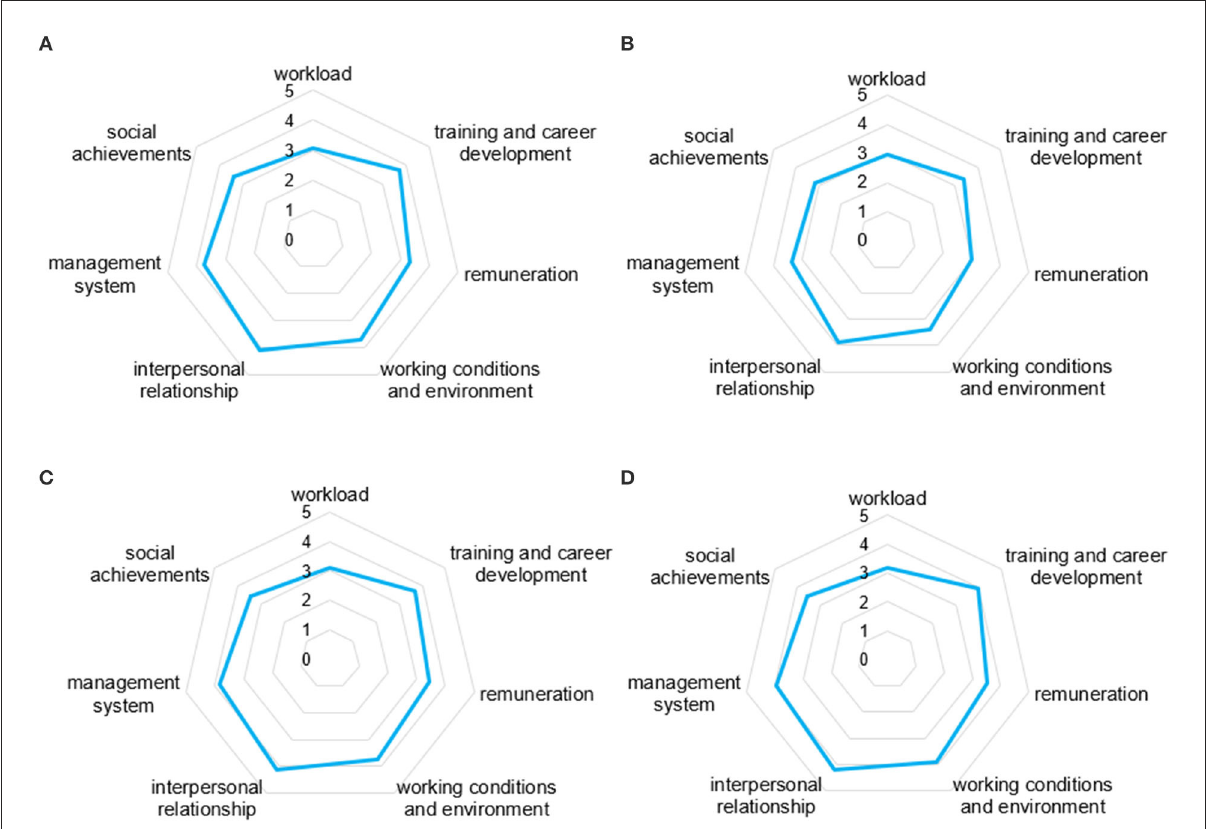
FIGURE1 Radar chart of job satisfaction results of FPTMs. (A) In general and three regions, (B) Jinan, (C) Weifang, and (D)